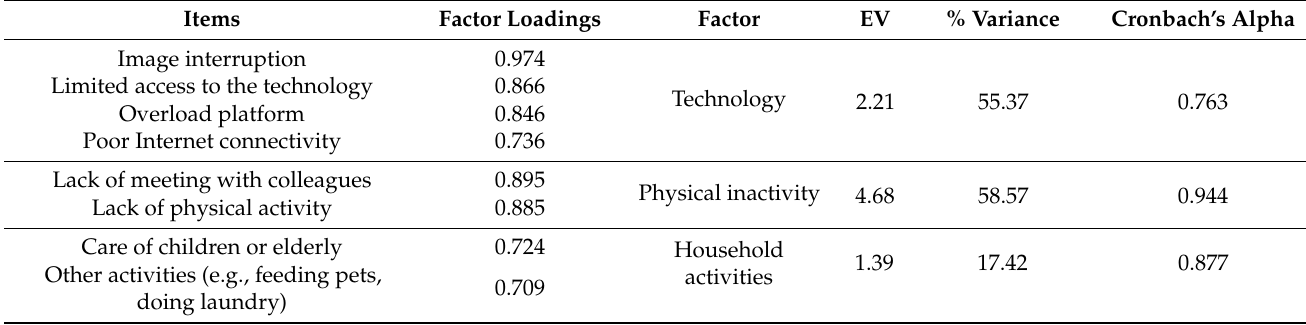
Table 6. Testing data from the auxiliary and non-teaching staff group.